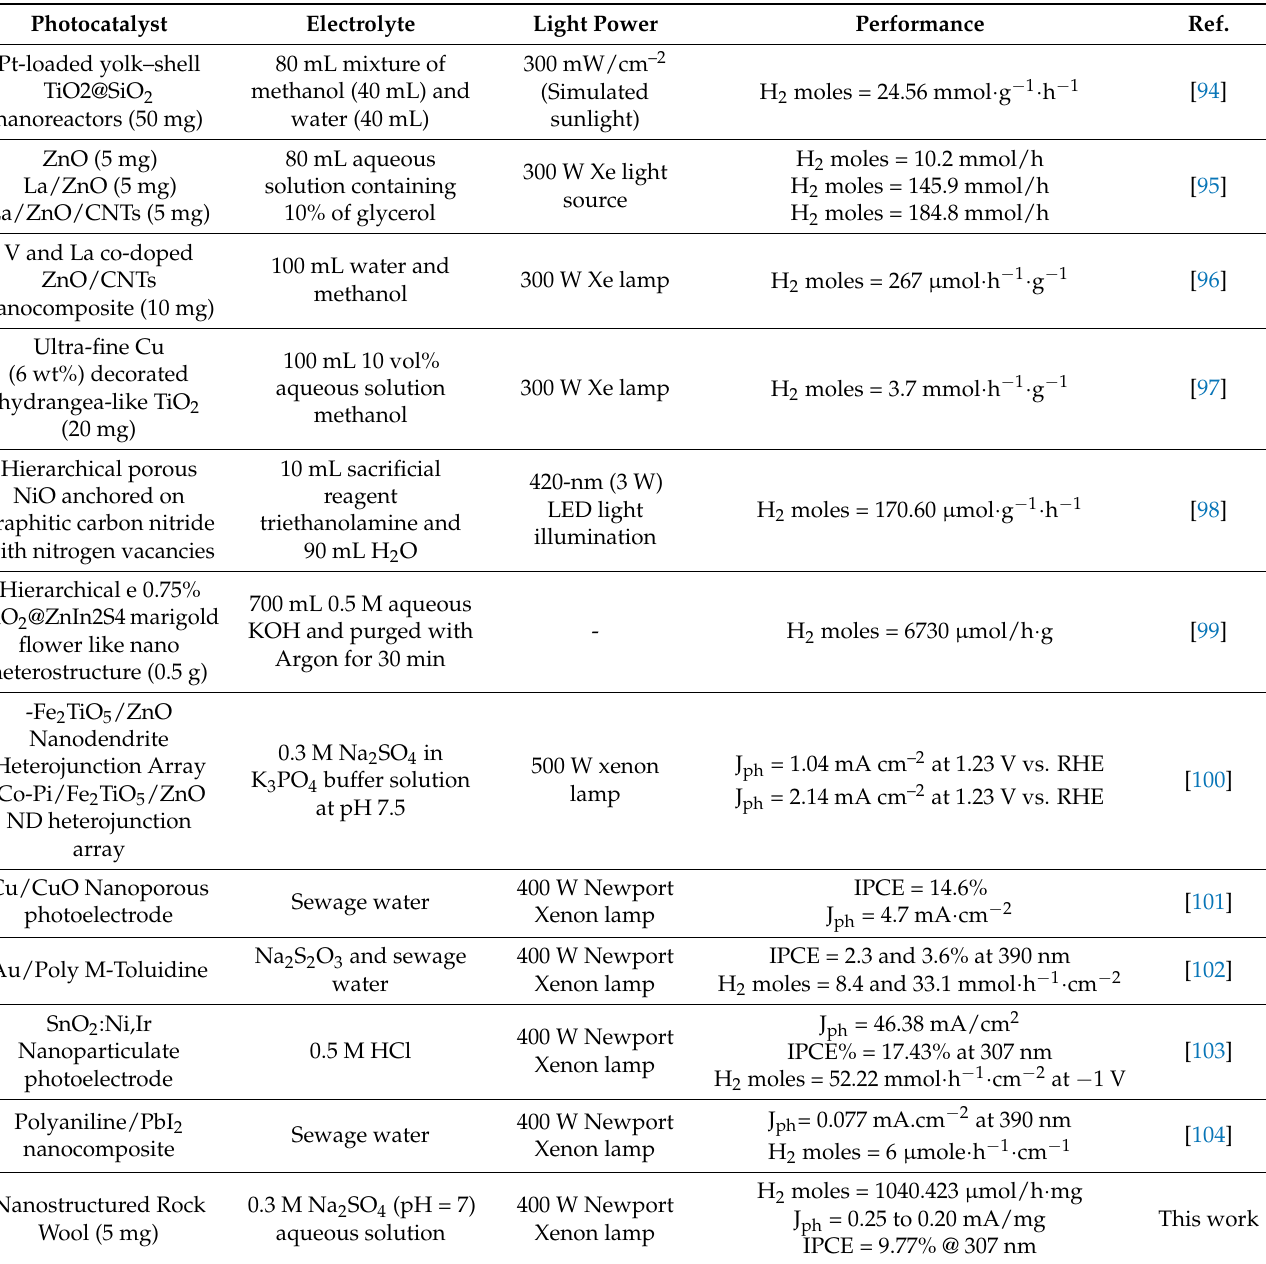
Table 2. Comparison between the present photocatalyst and the recently reported literature in terms of composition, electrolyte, light power or source, main performance indicators (H 2 moles, J ph , or IPCE%